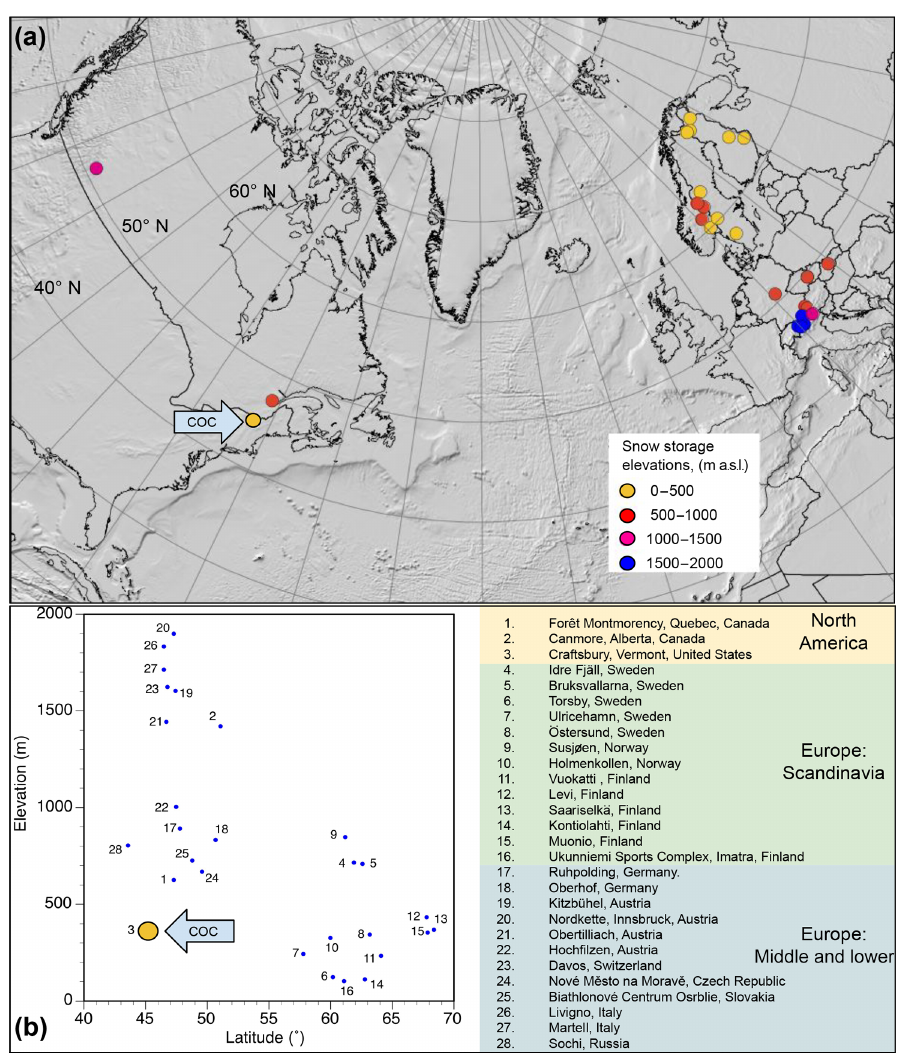
Figure 1. Locations of known over-summer snow storage sites (both currently active and inactive). (a) Conical projection shows known locations of over-summer snow storage at nordic ski centers. The Craftsbury Outdoor Center is highlighted with a blue arrow, which is labeled COC. The relative elevations of ski centers are displayed as a color gradient, marked in the legend. (b) Scatterplot of same locations as shown in (a) . The Craftsbury Outdoor Center (no. 3) is large yellow dot (COC). It has the lowest combination of elevation and latitude of any snow storage yet